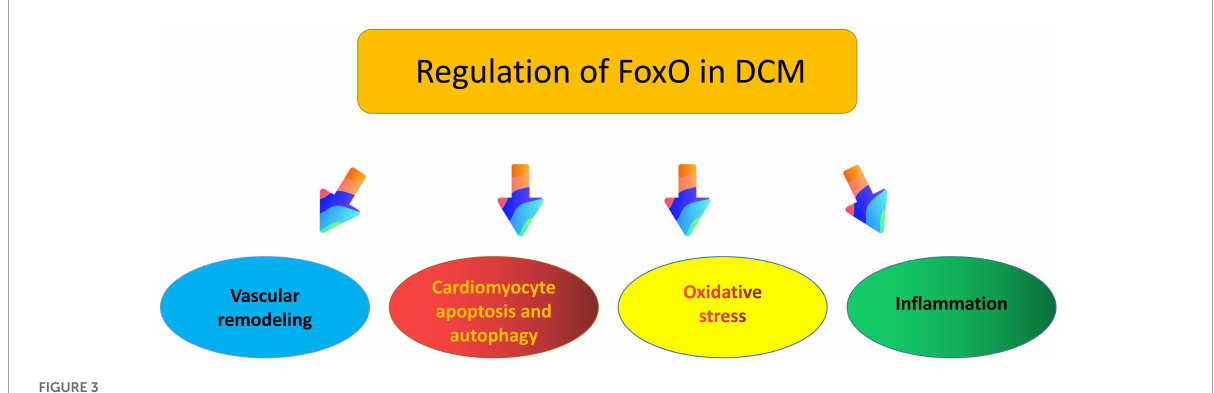
FIGURE3 Putative roles of FoxO in the pathogenesis of diabetic